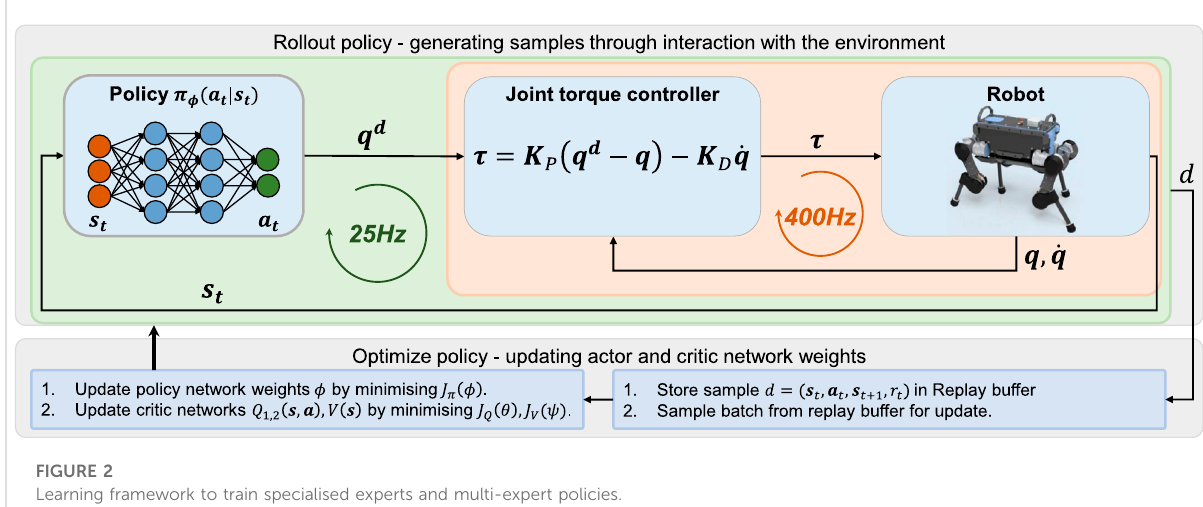
FIGURE 2 Learning framework to train specialised experts and multi-expert